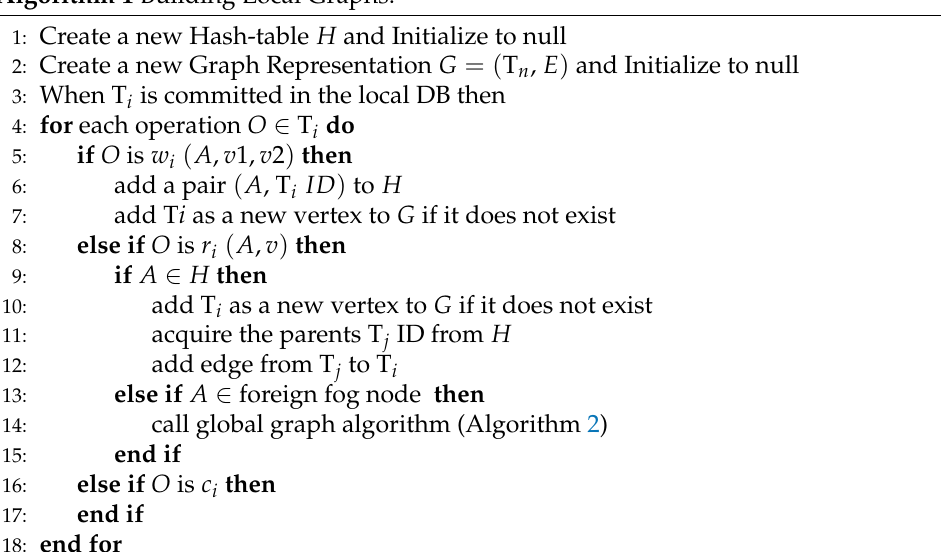
Algorithm 1 Building Local Graphs.